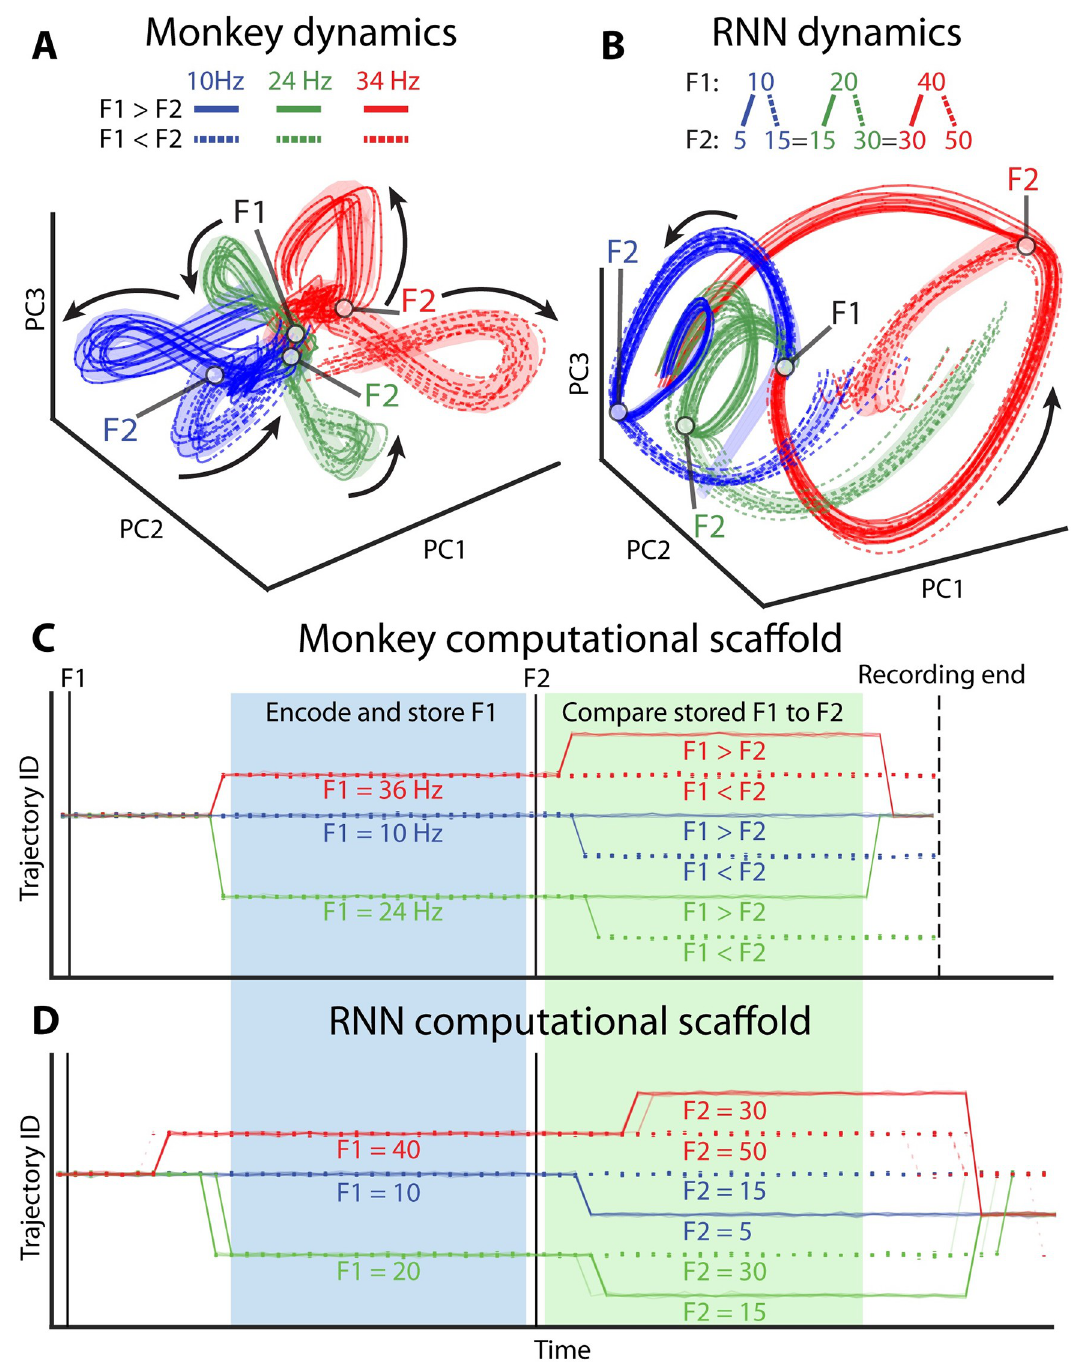
Fig 3. Computational scaffold is conserved between monkey and RNN despite disparate neuronal activity patterns. Mean subtracted activity in prefrontal cortex ( A ) and RNN ( B ) projected onto the first three principal components (56% variance explained in monkey, 83% explained in RNN). Thin lines show observed neuronal activity on a single trial (colored by task condition). Stable trajectories extracted by LOOPER are also projected onto these PCs(thick lines). Dashed lines indicate F1 < F2 and solid lines indicate F1 > F2. Shaded area reflects the variance of the data assigned to each model bin. The F1 and F2 stimulus timings are shown as white markers. Black arrows show phase velocity. Computational scaffolds constructed using LOOPER on monkey ( C ) and RNN ( D ) data. Both the RNN and monkey share the same number of trajectories and branching patterns, implying that they have the same computational scaffold. F1 causes the system to diverge into 3 distinct trajectories (Encode and store F1). F2 causes each of those trajectories to bifurcate (Compare stored F1 to F2). Note that the same F2 maps onto different trajectories depending on the value of F1. Thus, unlike F1 which is stored in the system dynamics, F2 information does not map onto a unique trajectory. https://doi.org/10.1371/journal.pcbi.1010784.g003 PLOS Computational Biology | https://doi.org/10.1371/journal.pcbi.1010784 January6, 2023 10 /